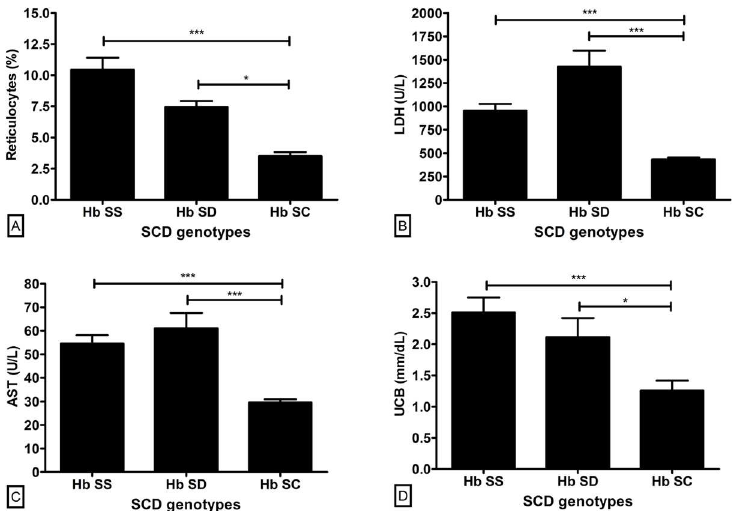
Fig 1. Hemolytic status in the SCD genotypes. (A) Reticulocytes. (B) LDH. (C) AST. (D) UCB. LDH: lactate dehydrogenase. AST: aspartate aminotransferase. UCB: unconjugated bilirubin. U/L: unit per liter. mm/dL: millimeter per deciliter. Reference values: Reticulocytes (1.0–2.6%); LDH ( < 480 U/L); AST ( < 31 U/ L); UCB ( < 0.7 mm/dL). Statistical analysis: Kruskal-Wallis followedby Dunn’s test for A and B; one-way ANOVA followedby Tukey’s test for C and D. * p < 0.05. *** p < 0.001.